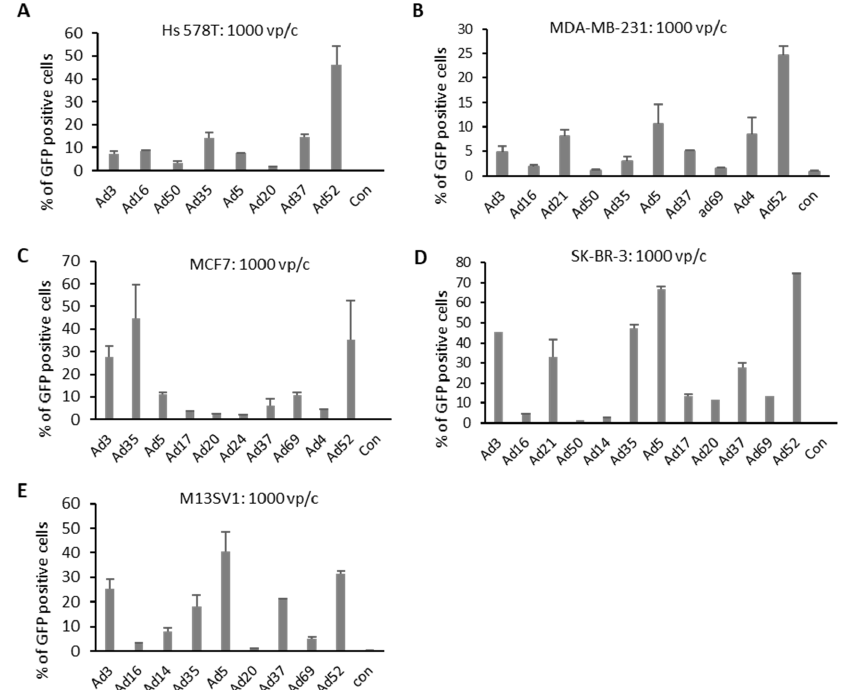
Figure 3. Number of GFP-positive cells after virus infection. Cells were infected with 10 Ads at 1000 viral particle per cell (vp / c), and GFP expression levels were analyzed 24 h postinfection by flow cytometry analyses. Uninfected cells (negative controls) were used to set the background gate below 1%. Percentage provided indicates percent of GFP-positive cells. A total of 10,000 viable cells were Error bars represent mean ± SD ( n =